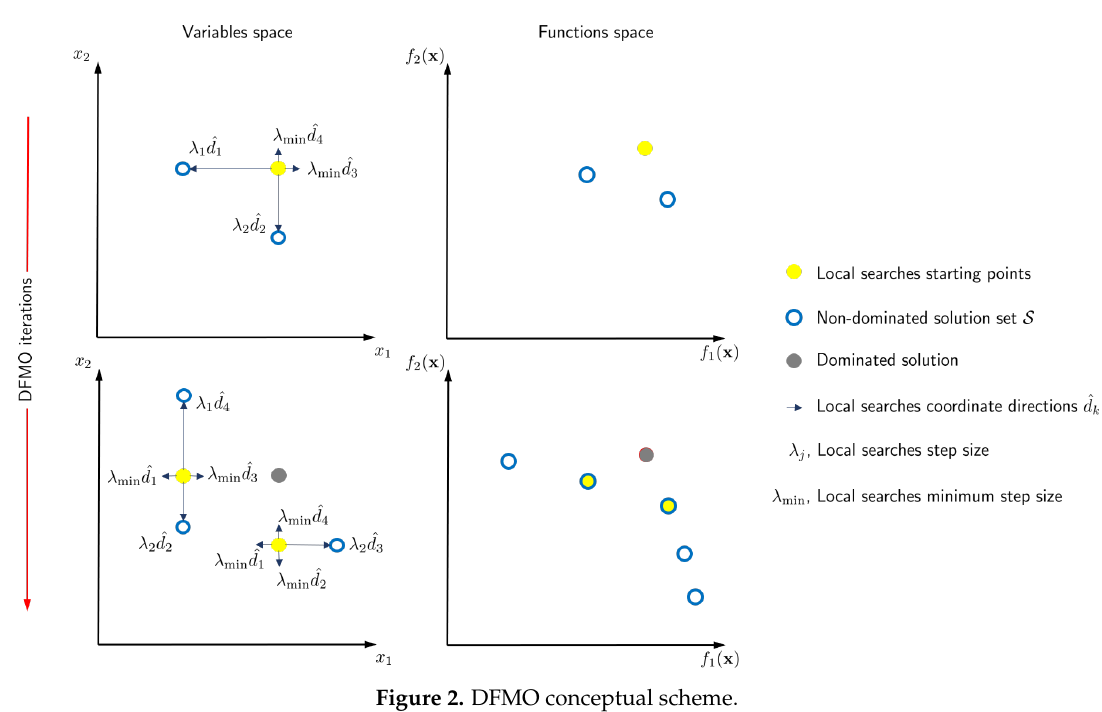
Figure 2. DFMO conceptual